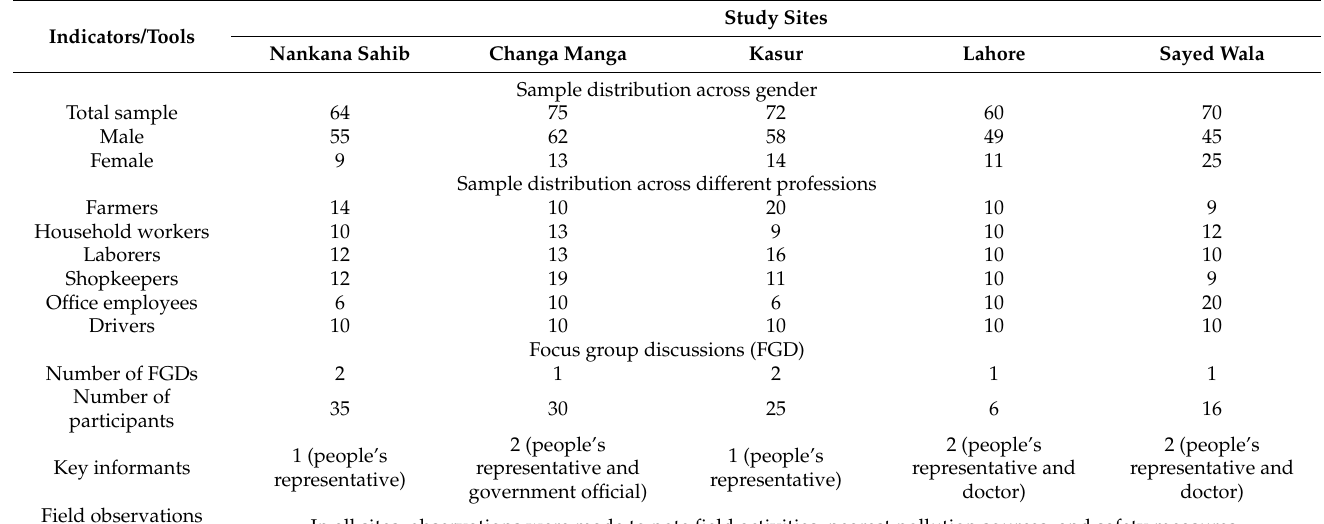
Table 1. Summary of sample size and data collection